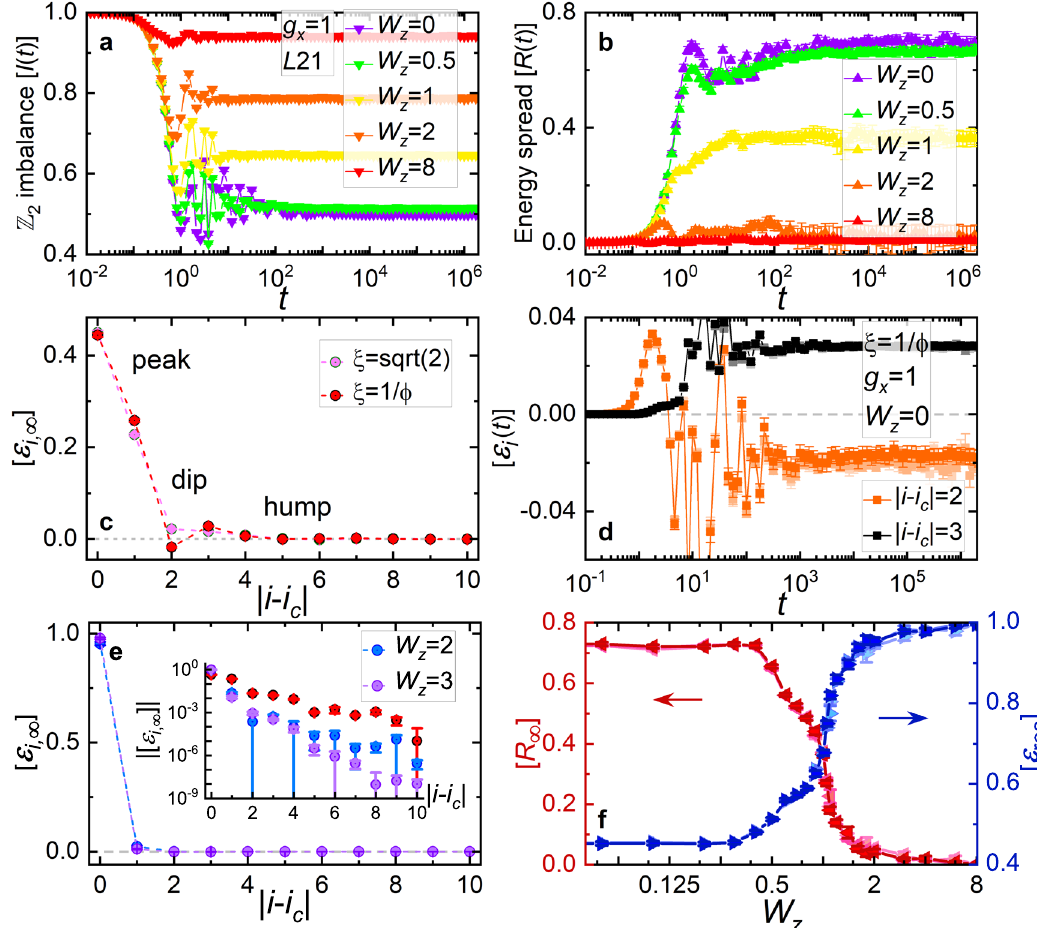
Fig. 7 cMBL-dMBL transition in transport with PBCs and fi xed g x = 1, L = 21. a , b Time evolution of the Z 2 antiferromagnetic imbalance [ I ( t )] and the energy spread [ R ( t )] as a function of W z . c exempli fi es the peak-dip-hump lineshape of [ ε i , ∞ ] in cMBL for two irrational wavenumbers ξ . One set of time-pro fi les of ½ ε i ð t Þ(cid:3) that characterizes the nonmonotonicity of the dip-hump structure is given by d . e shows c ±2 ; 3 the lineshape of [ ε i , ∞ ] in dMBL; the exponential decay can be seen from the semi-log inset wherein the cMBL data (pink dots) are overlaid for comparison. f The changes in dynamic `\lq order parameters ’ [ R ∞ ] and ½ ε res (cid:3) under the tuning of W z signal the transition between cMBL and dMBL. Light to solid colors in d , f correspond to L = 17, 19,